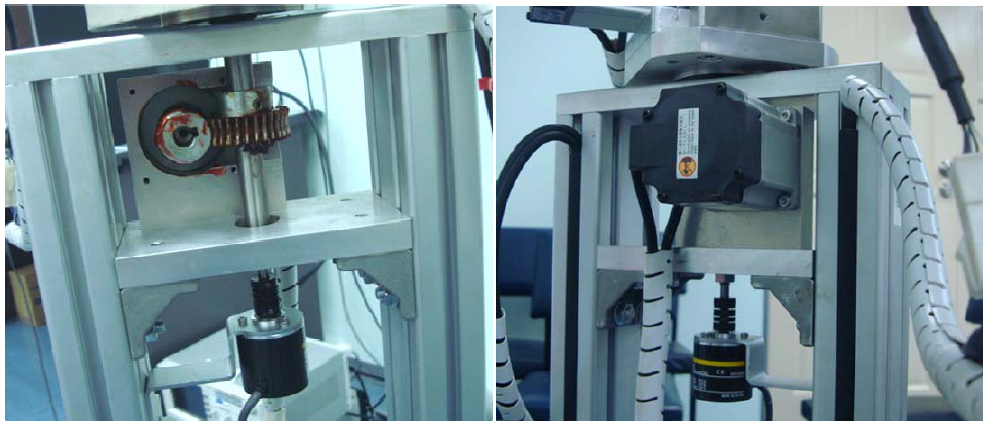
Figure 7. The mechanism of the first